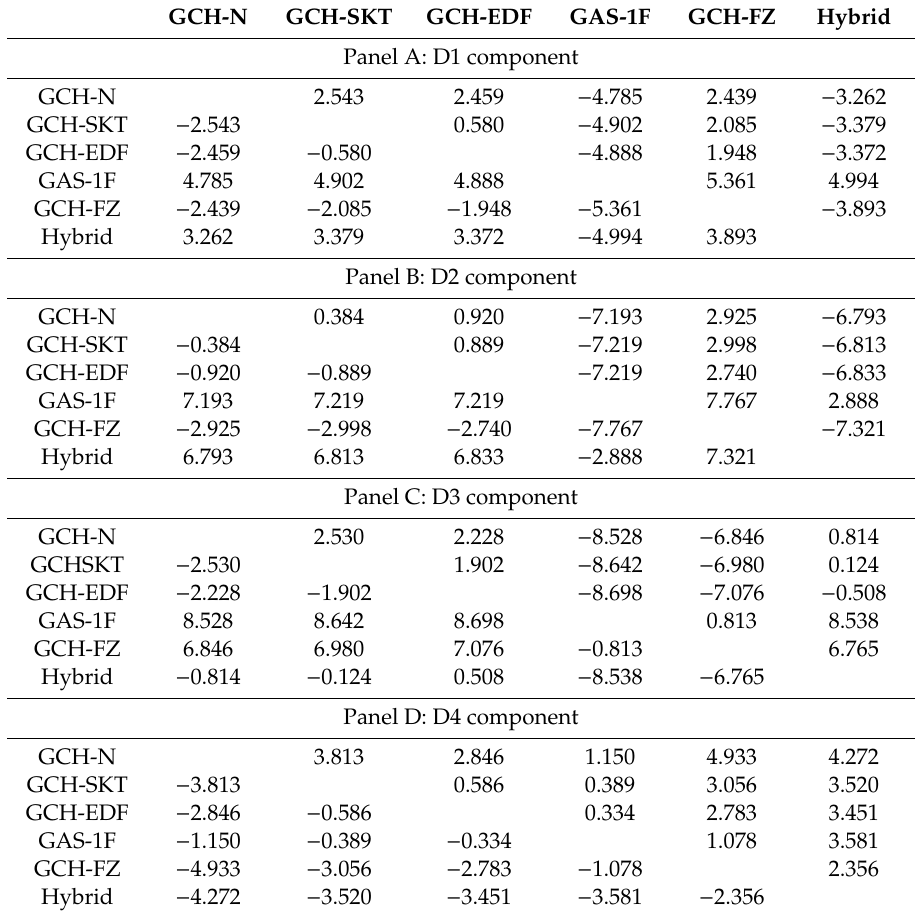
Table 7. The Diebold − Mariano t -statistics for the average out-of-sample loss di ff erences ( α = 0.05,